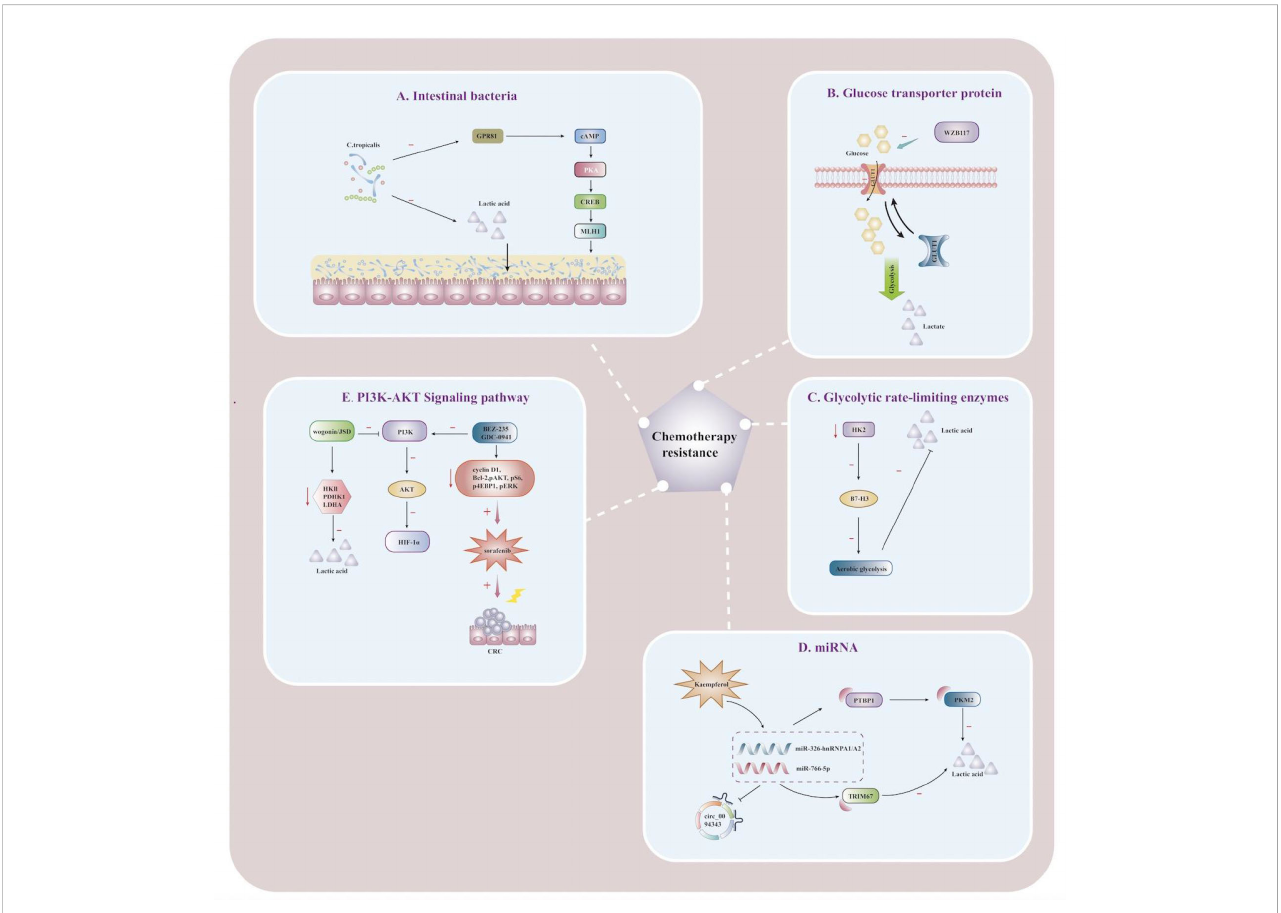
FIGURE 2 Lactate affects the immunometabolic mechanism of chemoresistance in CRC Schematic illustration showing mechanisms of action associated with targeting lactate metabolic reprogramming to reverse chemoresistance in CRC cells. (A) Schematic illustration showing the effect of lactic acid fermented by Clostridium tropicalis on chemotherapy tolerance in CRC patients. When Clostridium tropicalis produces large amounts of lactate, the GPR81-cAMP-PKA-CREB axis is activated, and MLH1 expression is downregulated, increasing chemotherapy tolerance. (B) Schematic illustration showing lactate regulation and reversal of chemotherapy resistance mediated by the mechanism of regulating gene expression by miRNA. circ_0094343 inhibits glycolysis of CRC cells through the miR-766-5p/TRIM67 axis, reduces lactate production, and enhances the sensitivity of chemotherapeutic drugs such as 5-FU. Dietary fl avonoid kaempferol can inhibit lactate production and reverse chemotherapy resistance by regulating the miR-326-hnRNPA1/A2/ PTBP1-PKM2 axis. (C) Schematic illustration showing the effects of glycolysis rate-limiting enzymes on lactate metabolism and drug resistance in CRC tumor microenvironment. When HK2 is inhibited, B7-H3-induced lactate and CRC chemotherapy resistance are reduced. (D) Schematic illustration showing the reversal of 5-FU resistance by PI3K/AKT pathway in CRC cells. Jiedu Sangen decoction (JSD) and wogonin can inhibit the PI3K/AKT pathway, down-regulate the expression of HIF-1 a , reverse the chemoresistance, and increase the apoptosis of CRC cells. (E) Schematic illustration showing the effect of the glucose transporter GLUT1 on lactate metabolism and 5-FU resistance. WZB117 can speci fi cally inhibit glucose transport by GLUT1, reduce glycolytic raw materials and lactate production, and improve 5-FU resistance. nosine monophosphate; PKA, protein kinase A; CREB, cAMP-response element binding protein; JSD, Jiedu Sangen decoction; HK2, hexokinase 2; MLH1, Recombinant MutL Homolog 1; PTBP1, Recombinant Polypyrimidine Tract Binding Protein 1;PKM2, Pyruvate kinase isozyme type M2; TRIM 67, Tripartite Motif Containing 67; HIF-1 a , hypoxia-inducible factor-1 a